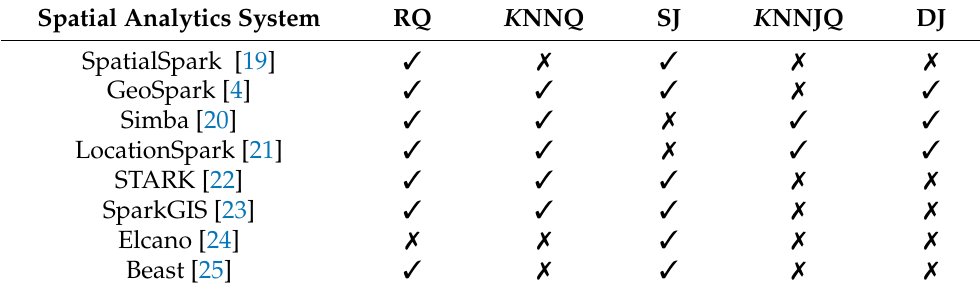
Table 1. Spatial queries supported in the most representative existing SASs based on Spark. Spatial Analytics